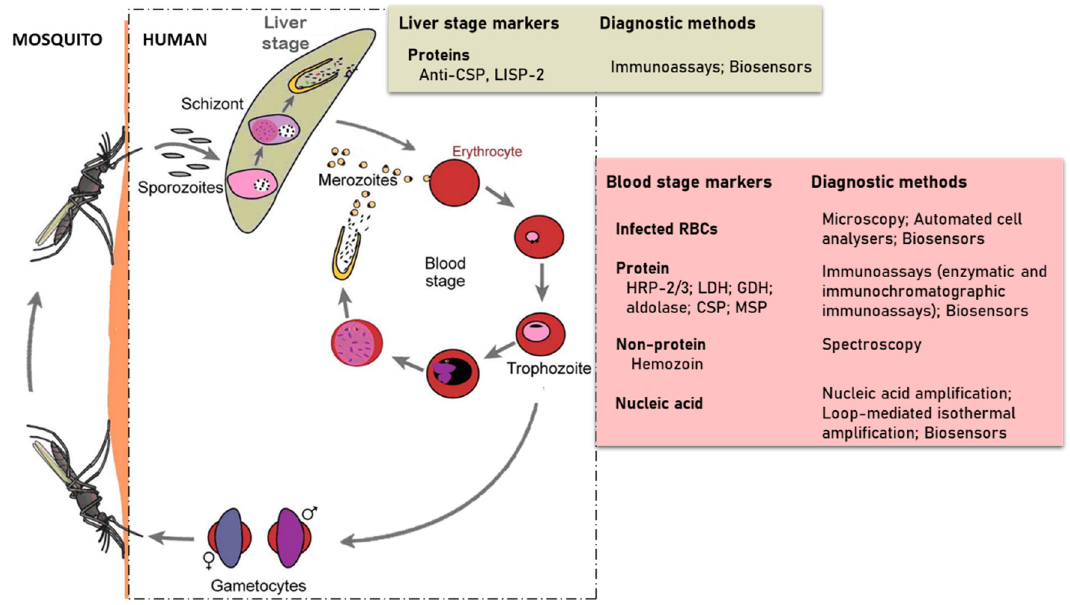
Figure 1. Developmental cycle of human Plasmodium species (redesigned from Scherf et al. 2008) in a mammalian host and the strategies used in detecting parasite specific markers. The erythrocytic stage of infection begins when merozoites released from the invade red blood cells (RBCs) and grow from the rings to trophozoites and schizonts stages of development. Schizonts egress to release merozoites that continue the cyclical asexual cycle. In the process, some of the